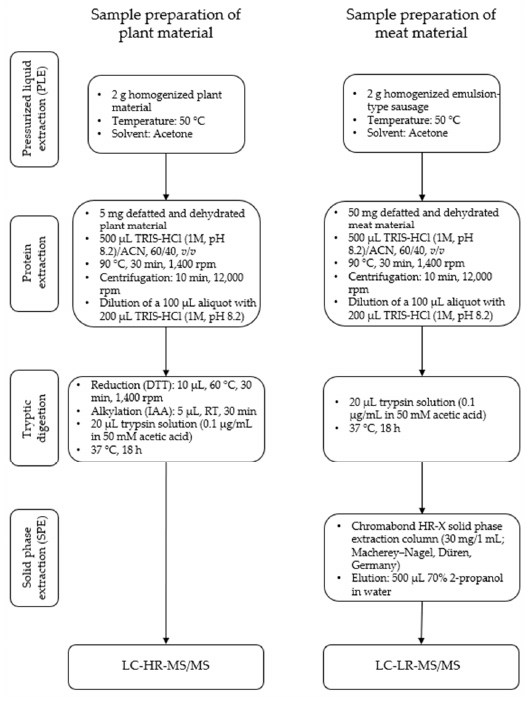
Figure 1. Experimental workflow for the sample preparation of oilseed meals (plant material) for LC-HR-MS/MS and emulsion-type sausages with added oilseed protein (meat material) for LC-LR-MS/MS.